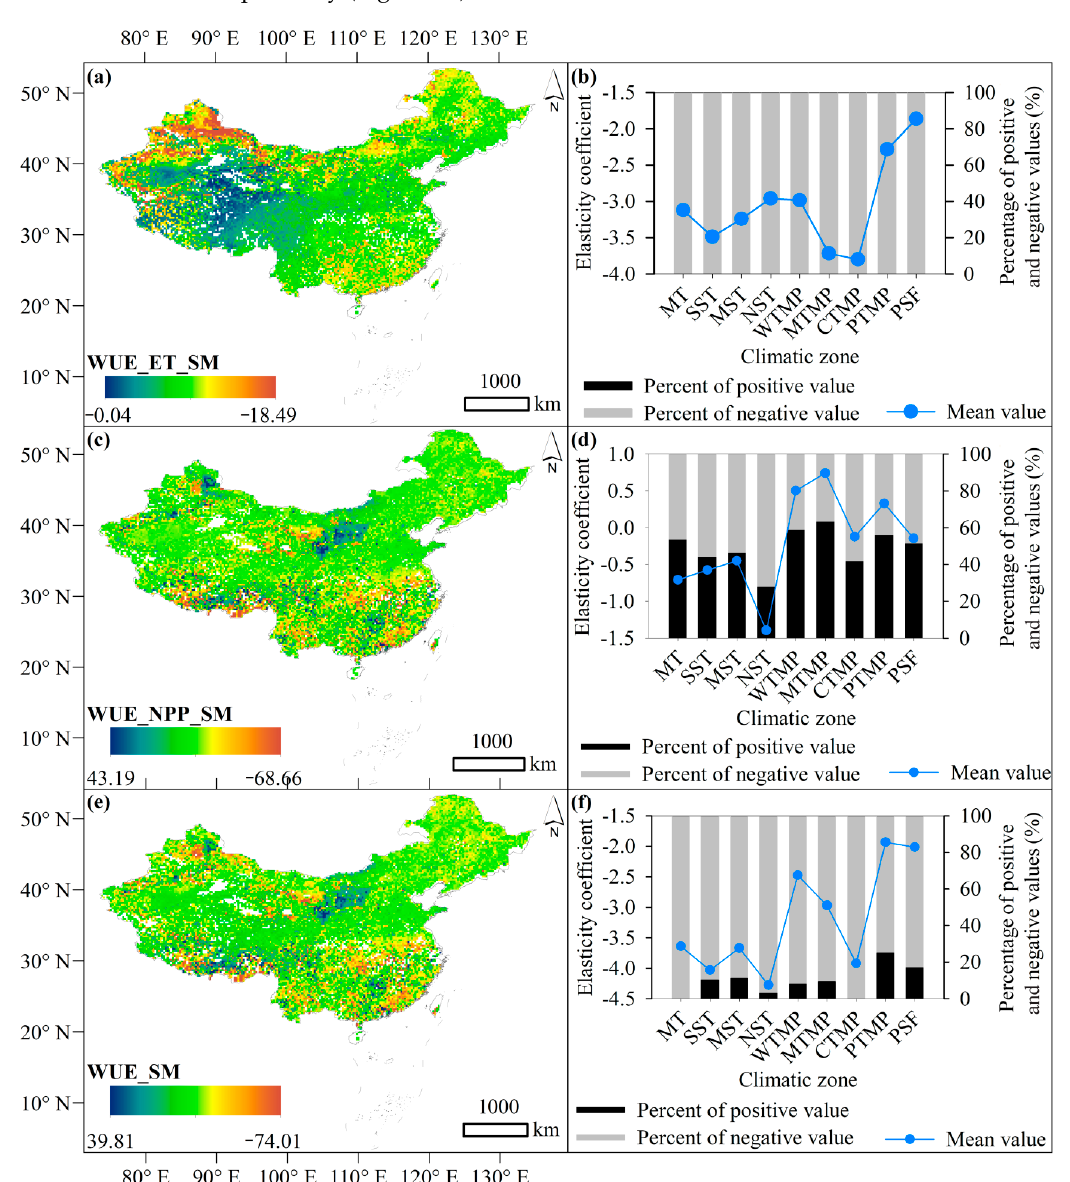
Figure 4. Spatial characteristics of the elasticity coefficient of water use efficiency ( WUE ) to soil moisture ( SM ) change in the growing season of the terrestrial ecosystem in China during 1985–2014. Panels ( a , c , e ) show the raster map of the sensitivity of WUE to SM variation via the evapotranspiration ( ET ) and net primary production ( NPP ) pathways and the final effects of both pathways, respectively. Panels ( b , d , f ) show the sensitivity of WUE to SM variation via the ET pathway and NPP pathway and the final effects of both pathways in different climatic zones, respectively. The abbreviations of MT, SST, MST, NST, WTMP, MTMP, CTMP, PTMP, and PSF represent the marginal tropical zone, south subtropics zone, middle subtropics zone, north subtropics zone, warm temperate zone, middle temperate zone, cold temperate zone, temperate zone in Qinghai–Tibet Plateau and the sub-frigid zone in Qinghai–Tibet Plateau (PSF),